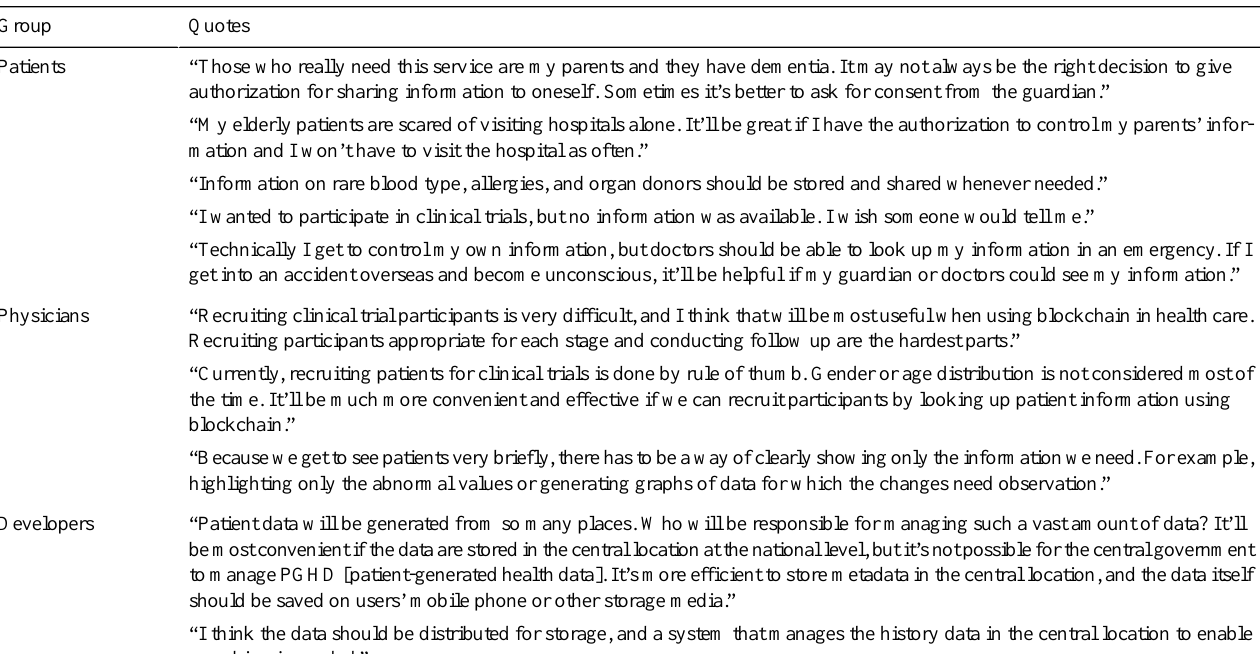
Table 7. Suggested functions of a blockchain-based hospital information exchange (HIE) system.